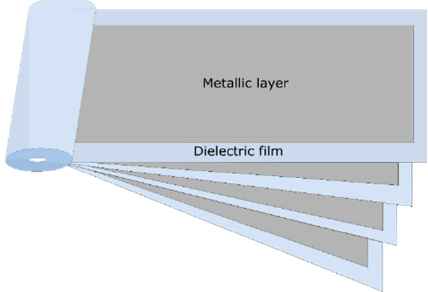
Figure 3. Stacked metallized capacitors.